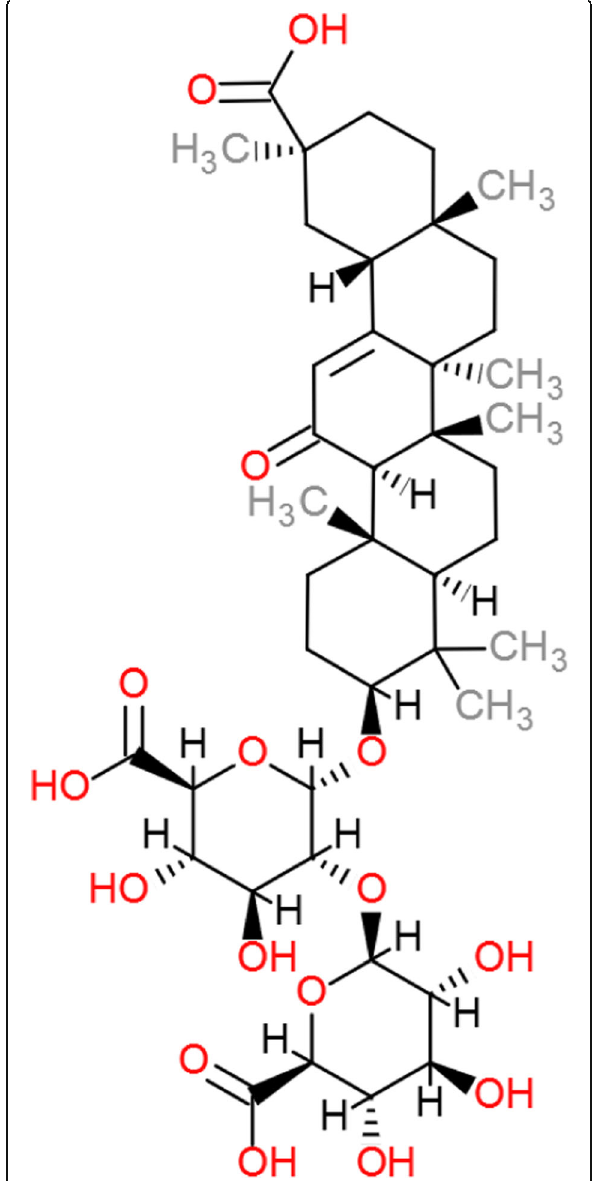
Fig. 3 The chemical structure of licorice, glycyrrhizin . Modified after Li et al. [29]. Glycyrrhizin is the sweet component of licorice which is metabolized to glycyrrhetinic acid. Glycyrrhizin has potential to be anti-inflammatory. However, it also has the ability to cause retention of sodium and loss of potassium, increasing blood pressure,